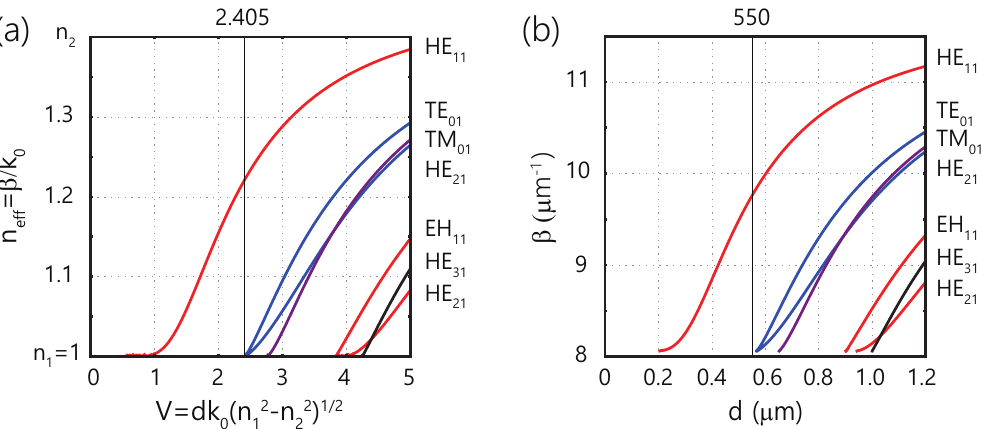
Figure 5. ( a ) Numerical solutions of effective refractive index, n eff = β / k 0 , as a function of V -number for the first seven modes. ( b ) Numerical solutions of propagation constant, β , as a function of diameter at 780